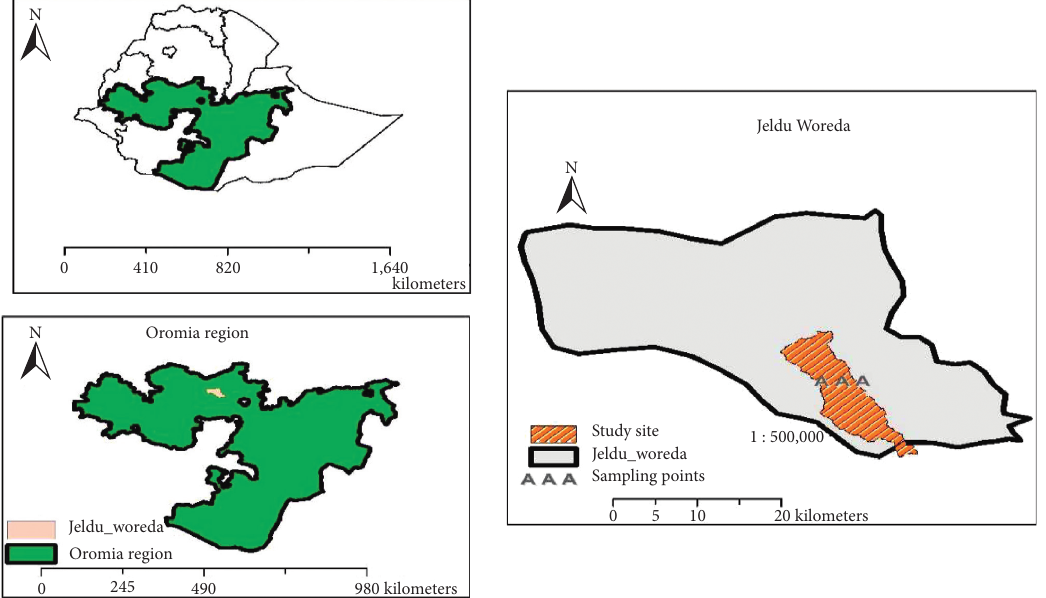
Figure 1: Map of the study